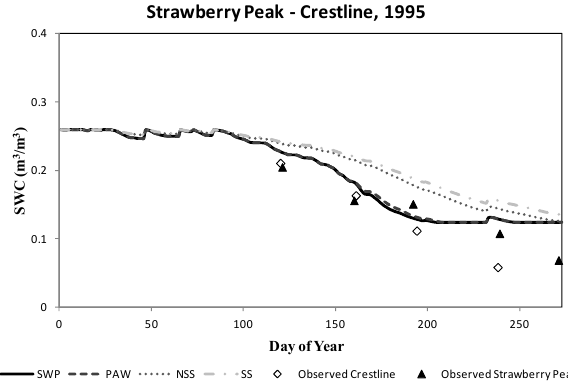
Fig. 11. Comparison of observed and modelled soil water con- tent (SWC) in 1995 for a evergreen oak stand at Strawberry Peak/Crestline using four methods that relate soil water to g sto (see methods section for details).